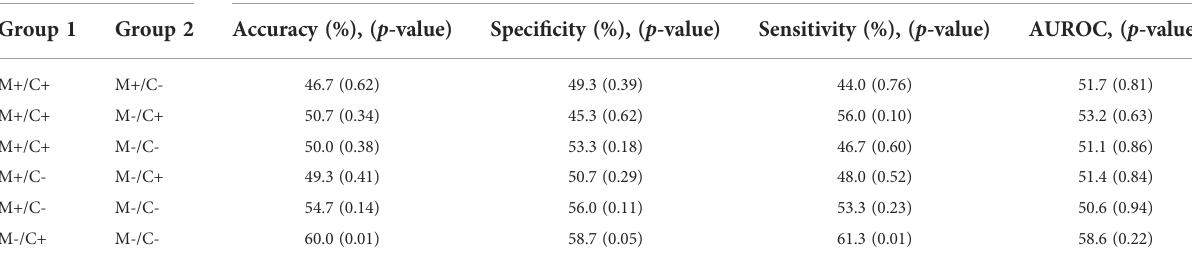
FIGURE 5 Scatter plot of principal component analysis (PCA) representing the human milk protein pro fi le of mother-child dyads from the CHILD Cohort Study. Each point represents one dyad. No obvious differences can be observed among protein pro fi les of different mother-child allergy groups using this method.